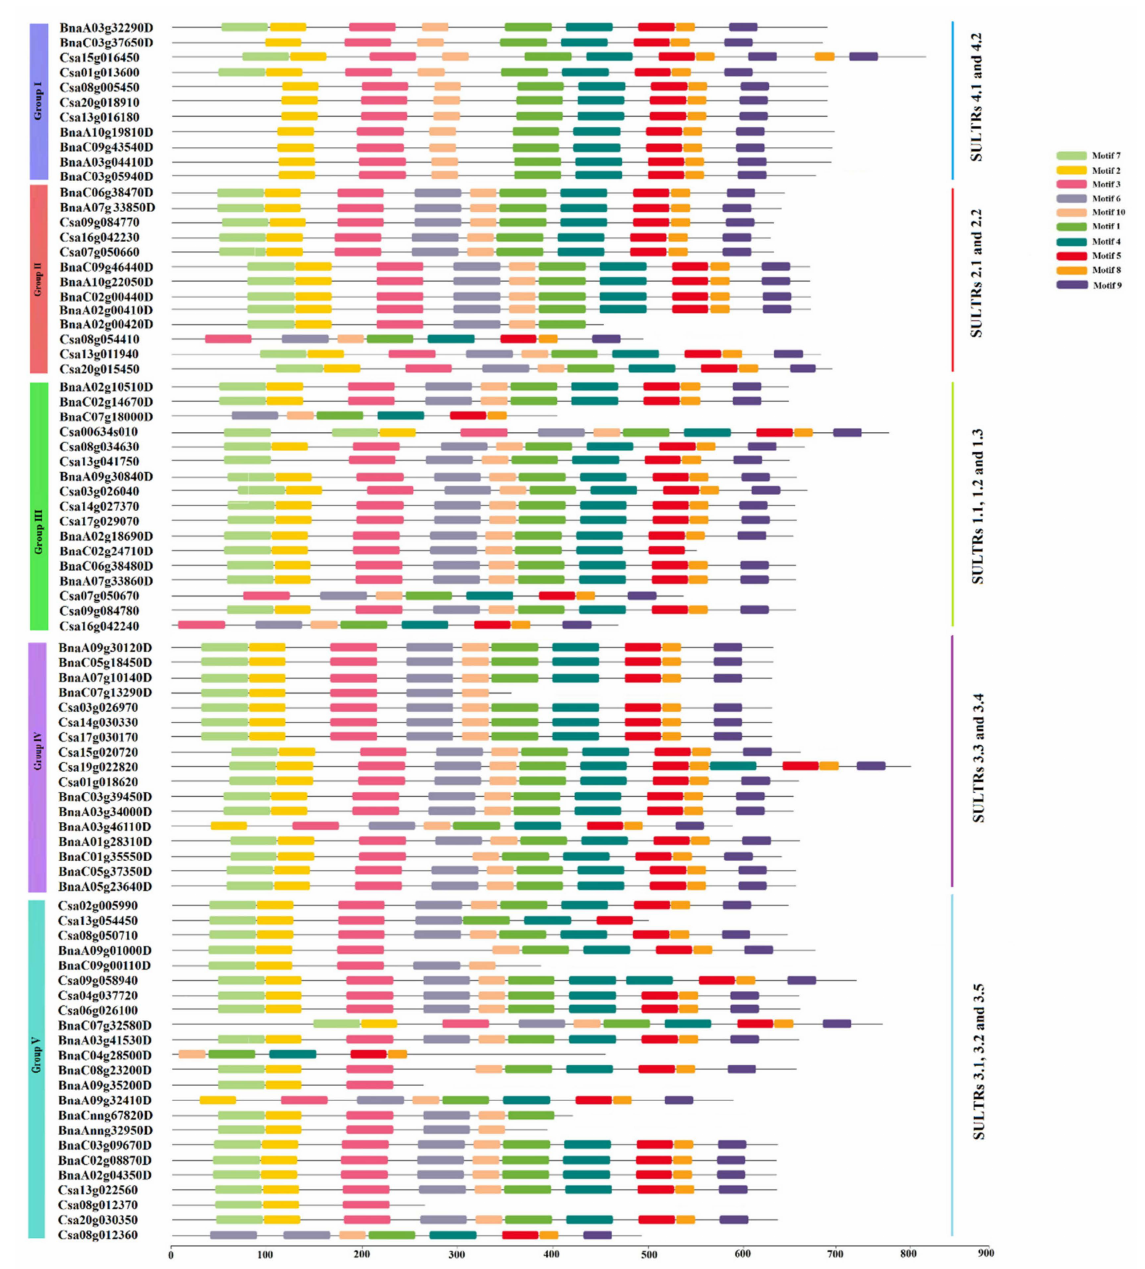
Figure 2. The distributions of the conserved motifs in the SULTRs from Camelina sativa and Brassica napus . The grouping was based on the phylogenetic tree. The sequences of the conserved motifs are presented in Figure